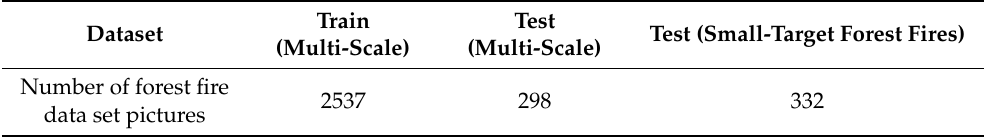
Table 1. Details of the data